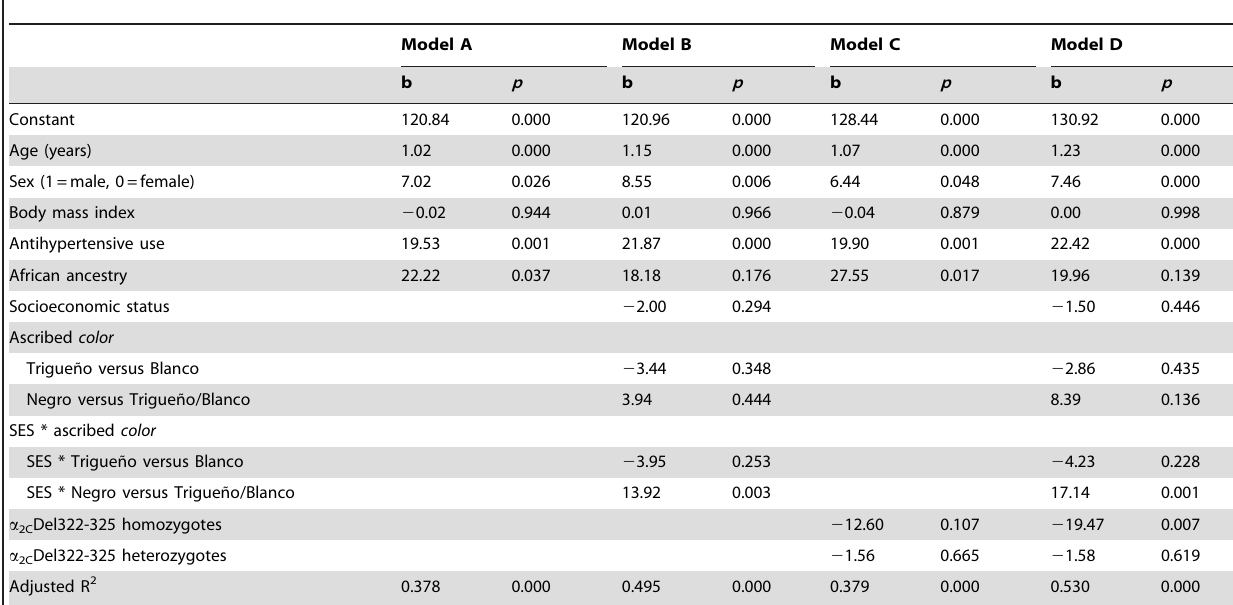
Table 2. Multiple linear regression coefficients (b) for systolic blood pressure (SBP) on genetic ancestry, ascribed color , socioeconomic status, a 2C adrenergic receptor genotype, and standard covariates.